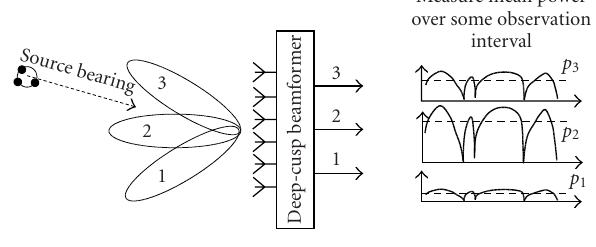
Figure 5: Applying the SDBM